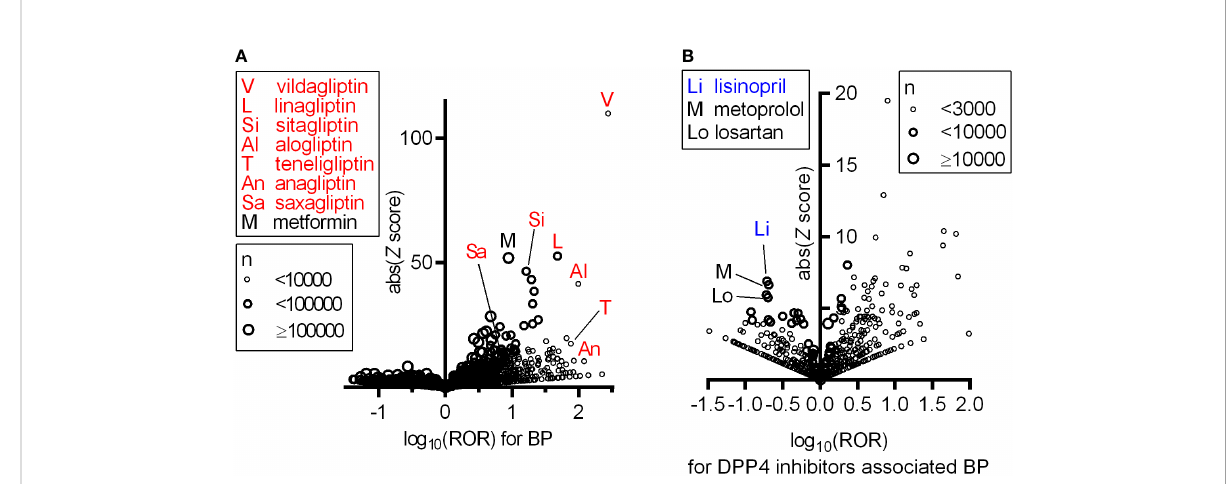
FIGURE 1 Increased ROR of BP with the use of DPP4 inhibitors and confounding effect of concomitant drugs on BP associated with DPP4 inhibitors based on FAERS data. In these volcano plots, RORs (log scale) and absolute scores are shown. Each circle indicates an individual drug, and circle size re fl ects the number of patients receiving the drug. (A) All DPP4 inhibitors appearing in the FAERS data showing strong and signi fi cant increases in the ROR of BP. (B) Confounding effects of concomitantly used drugs on the ROR of BP within the population prescribed any of the seven DPP4